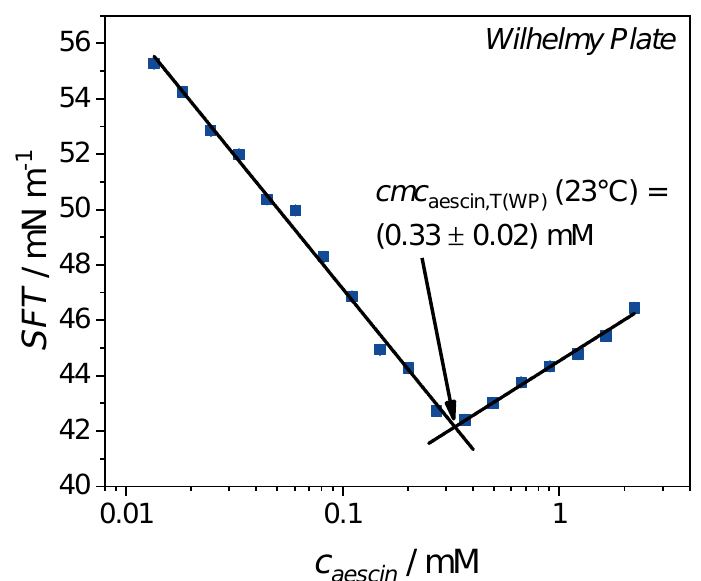
Figure 3. Surface tension isotherm of aescin in aqueous phosphate buffer at a temperature of 23 ◦ C recorded with the Wilhelmy Plate (WP) method. The intersection of the two linear regressions defines the cmc aescin,T(WP) value. The increase in surface tension (SFT) above cmc aescin,T(WP) might result from impurities of the aescin powder